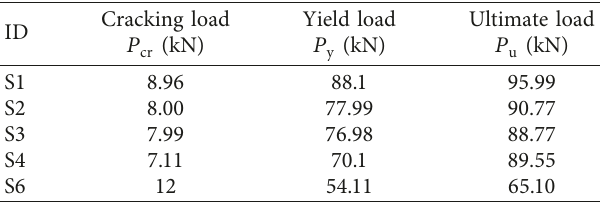
Table 4: Loading bearing capacity of the specimens.